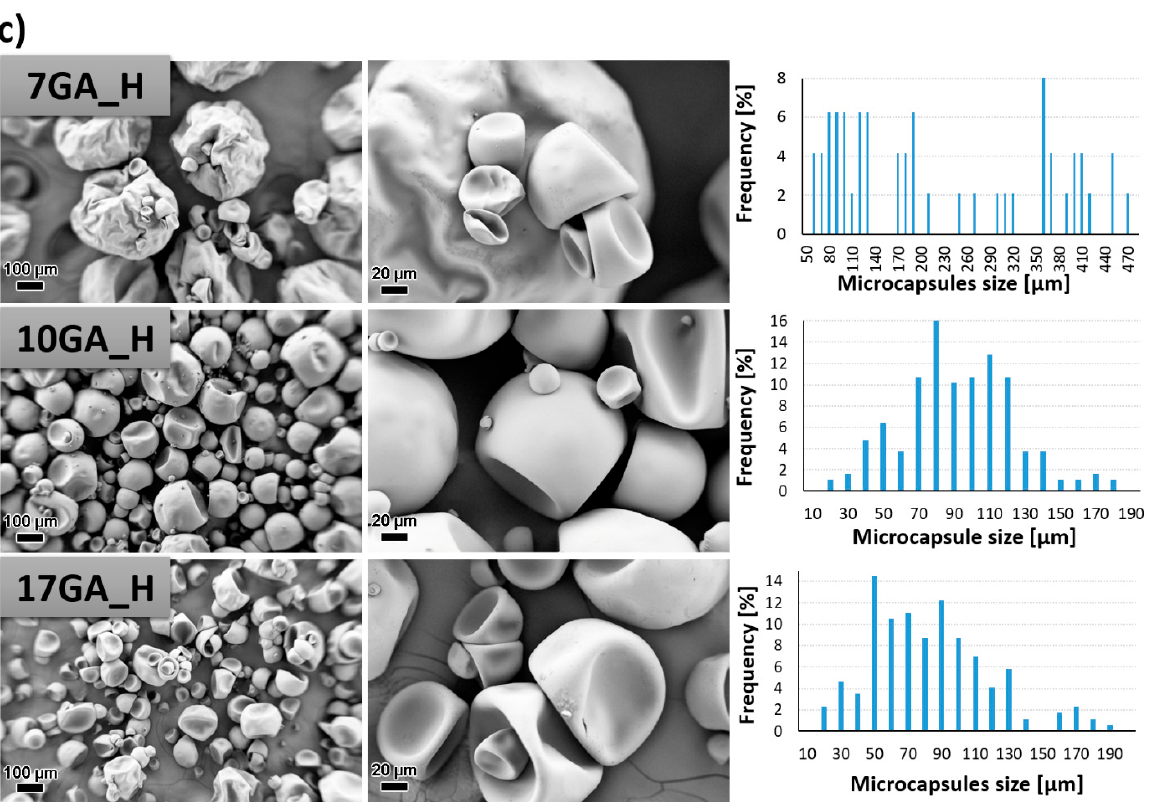
Figure 7. SEM micrographs taken under 200 × (left column) and 1000 × magnification (middle column) and size distribution of the prepared polyurethane (PU) microcapsules filled with isophorone diisocyanate (IPDI) (right column), prepared with various concentrations of gum arabic (GA) and prepolymer TDIprep_G ( a ), TDIprep_B ( b ) and TDIprep_H ( c ) .